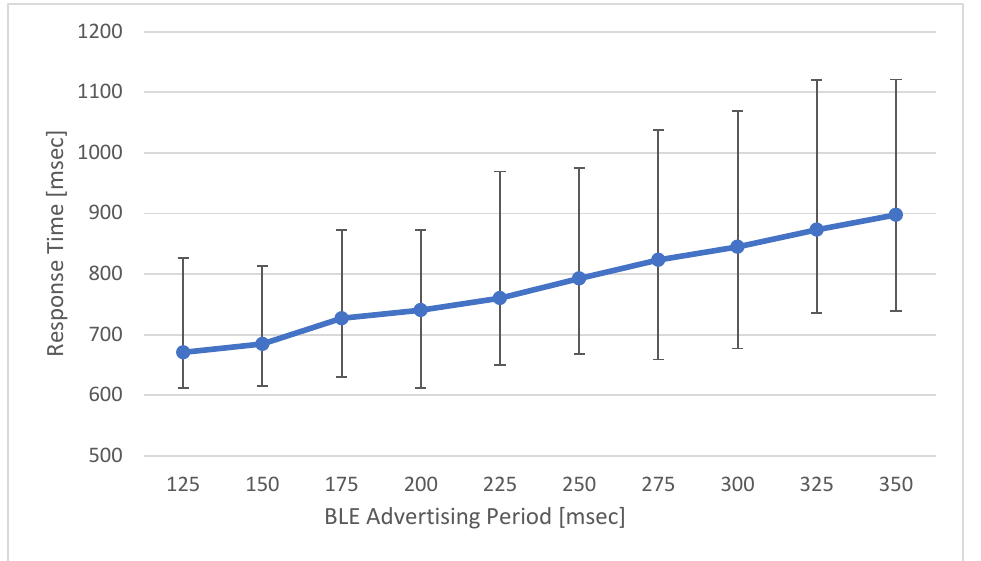
Figure 17. Response Time of ADL Report Protocol.